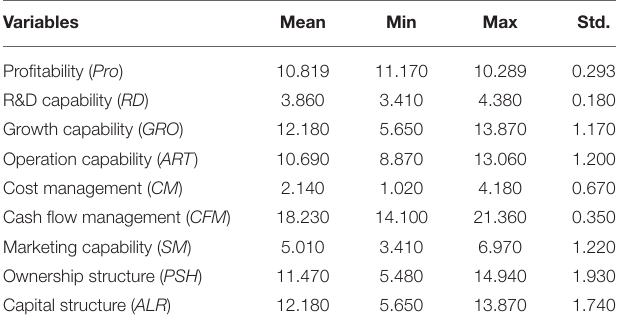
TABLE 1 | Descriptive statistics for variables.